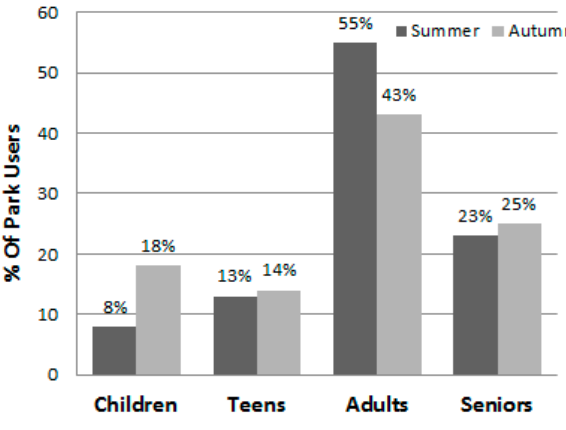
Figure 3. Percent of park users by season and age group ( n = 28,585).